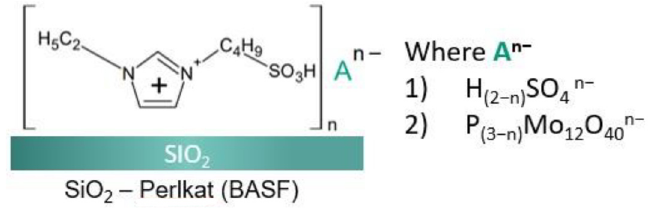
Figure 1. The composition of the obtained